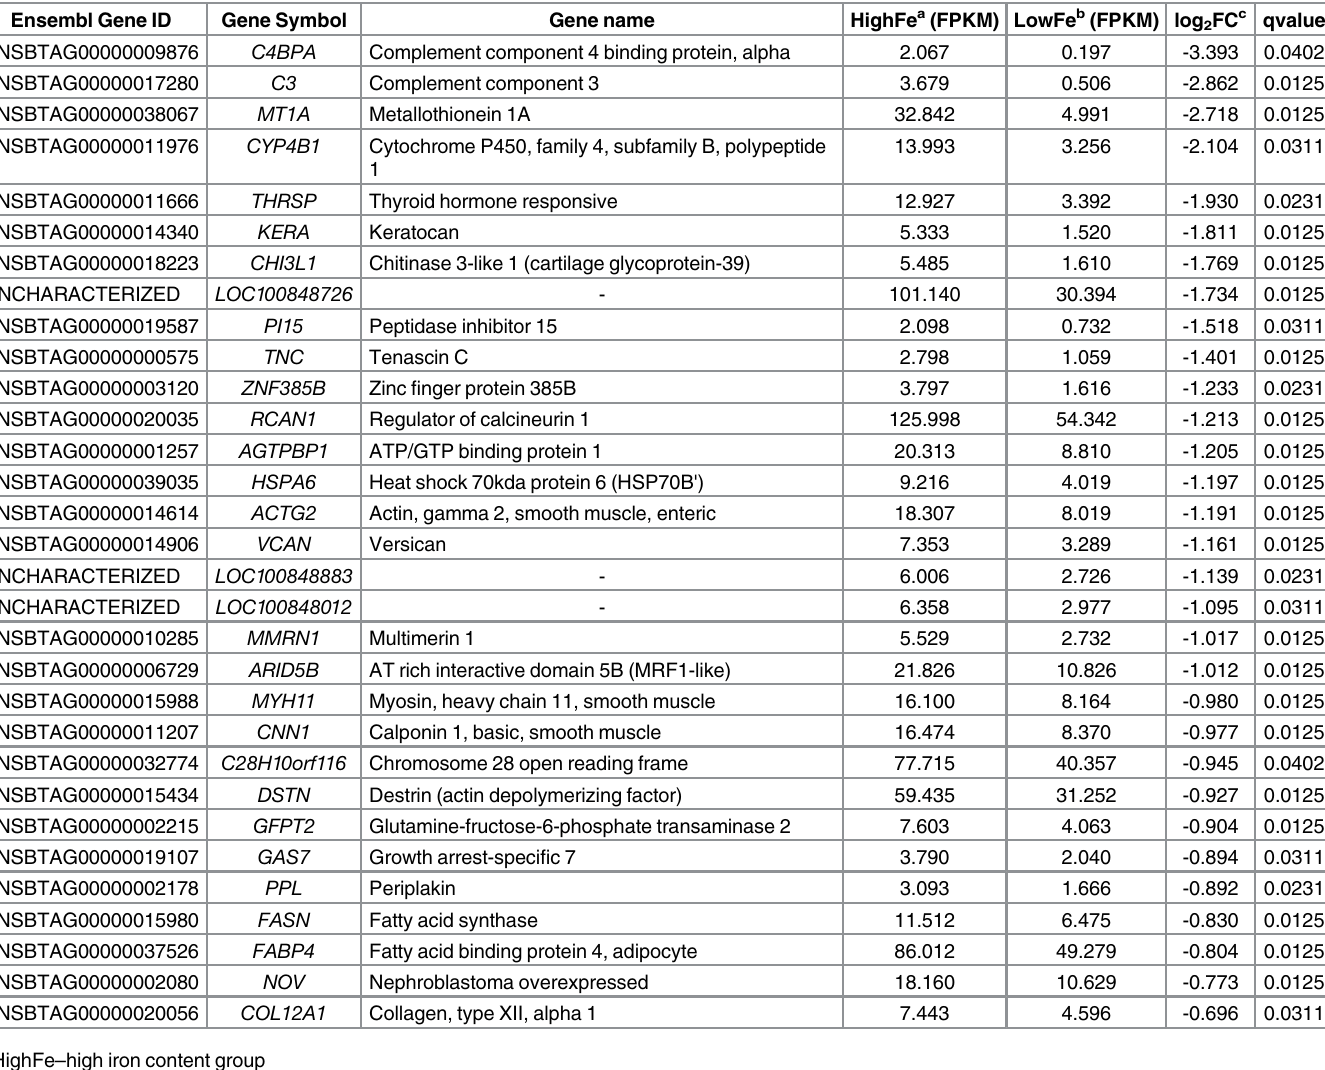
Table 3. Significantly down-regulated genes identified in the Nelore steers Longissimus dorsi muscle with low genomic breeding value compared to animals with high genomic breeding value for iron